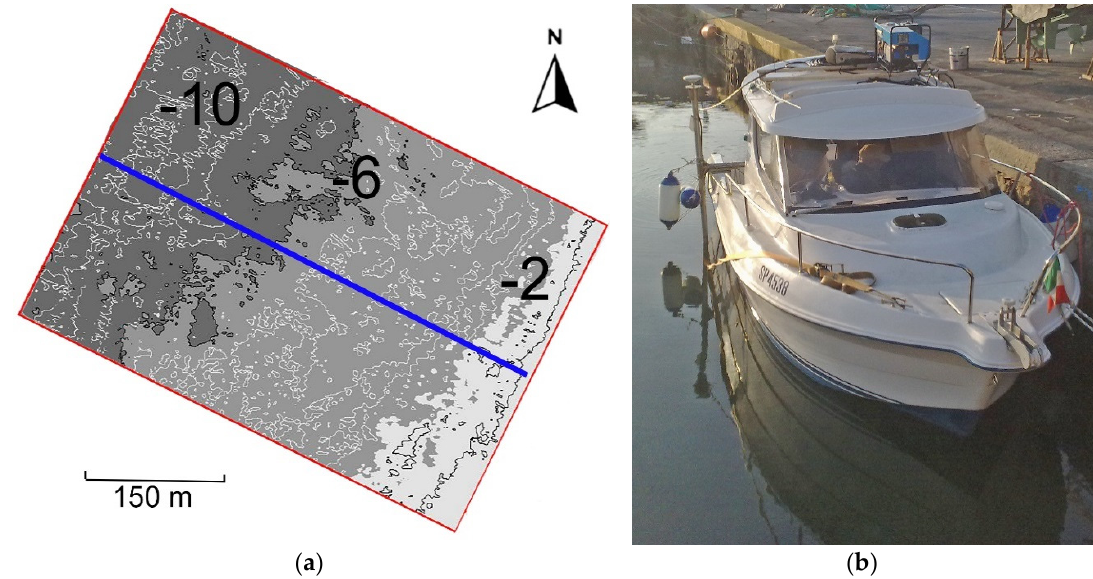
Figure 8. ( a ) 2018 real bathymetric survey map of the study area and the position of a central profile in blue. Depth is expressed in meters. ( b ) The boat used for the survey, with the Multibeam Echosounder (MbEs) mounted on the pole with the GPS.